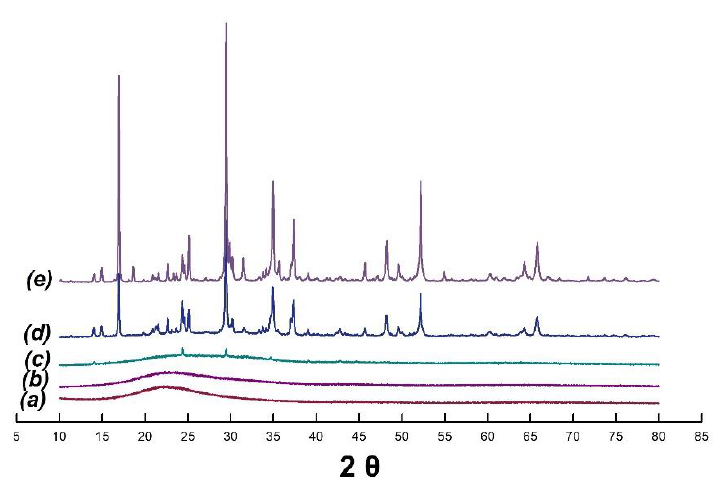
Figure 4. XRD diffractogram of NaNO 3 /SiAl x:1: (line a) support: heat-treated SiAl; (line b) NaNO 3 /SiAl 5:1; (line c) NaNO 3 /SiAl 10:1; (line d) NaNO 3 /SiAl 20:1; (line e) NaNO 3 /SiAl 40:1. As observed, the crystal phases changed as the amount of sodium nitrate increased.